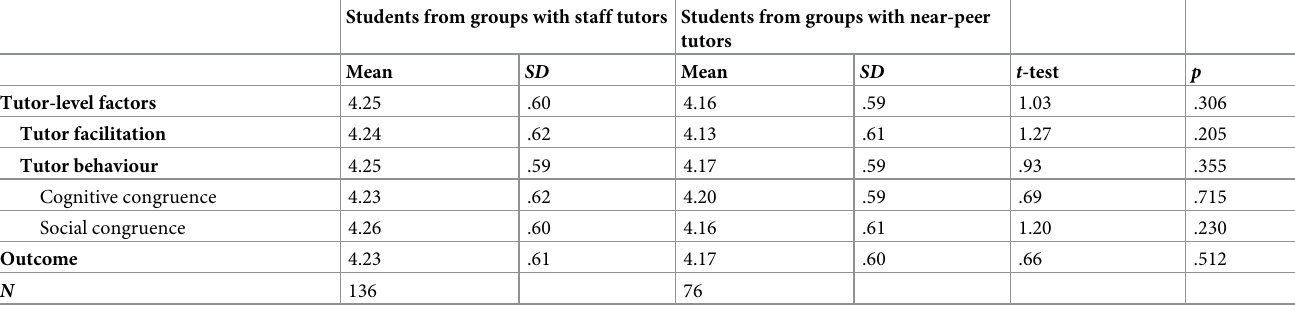
Table 1. Student perceptions of staff tutors’ vs. near-peer tutors’ facilitation and skills. Students from groups with staff tutors Students from groups with near-peer